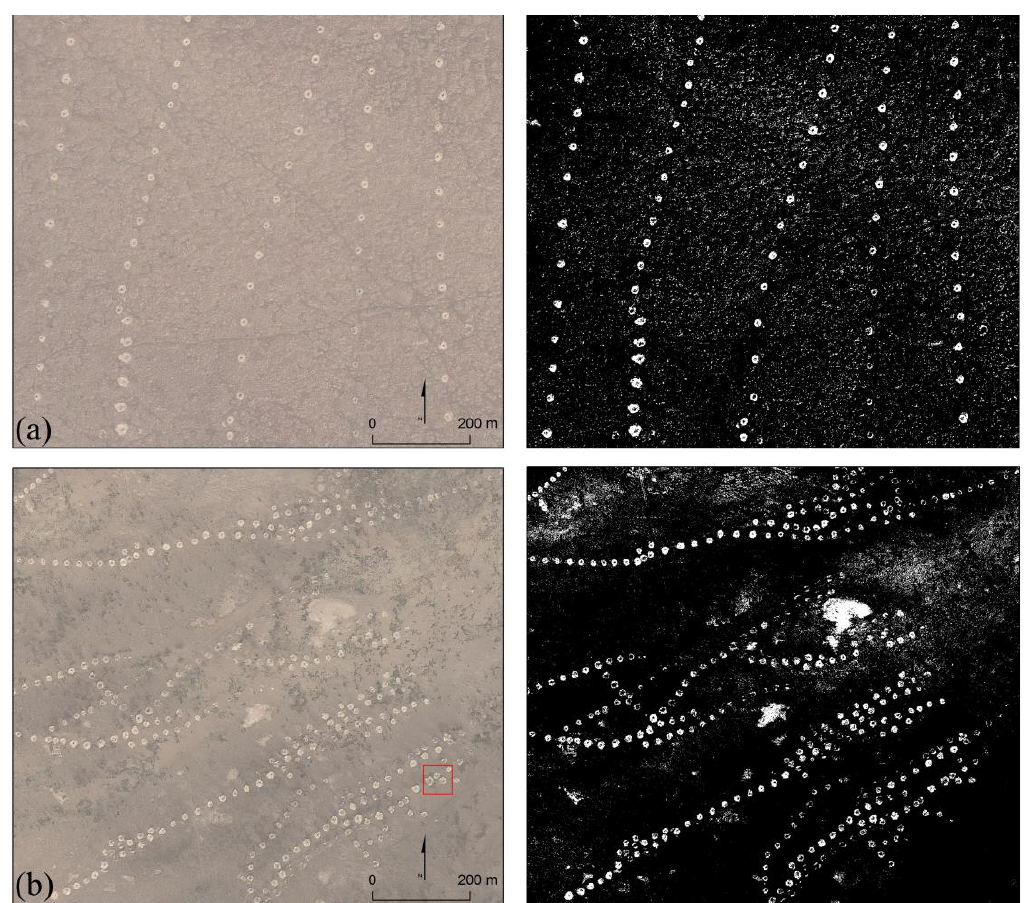
Figure 4. Google Earth VHR images of the test sites. The left and right panels show Google Earth VHR images of the test sites and derived binary images with threshold = 70, respectively. ( a ) Test Site 1. ( b ) Test Site